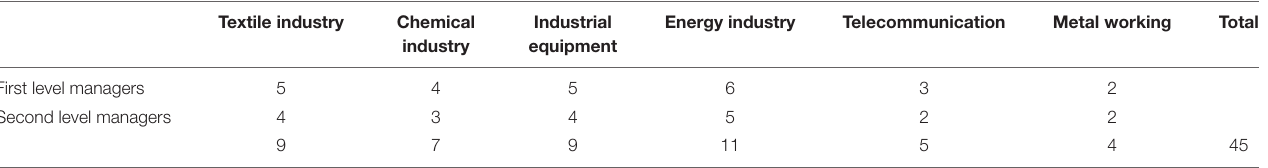
TABLE 1 | The type of organizations involved. Textile industry Chemical